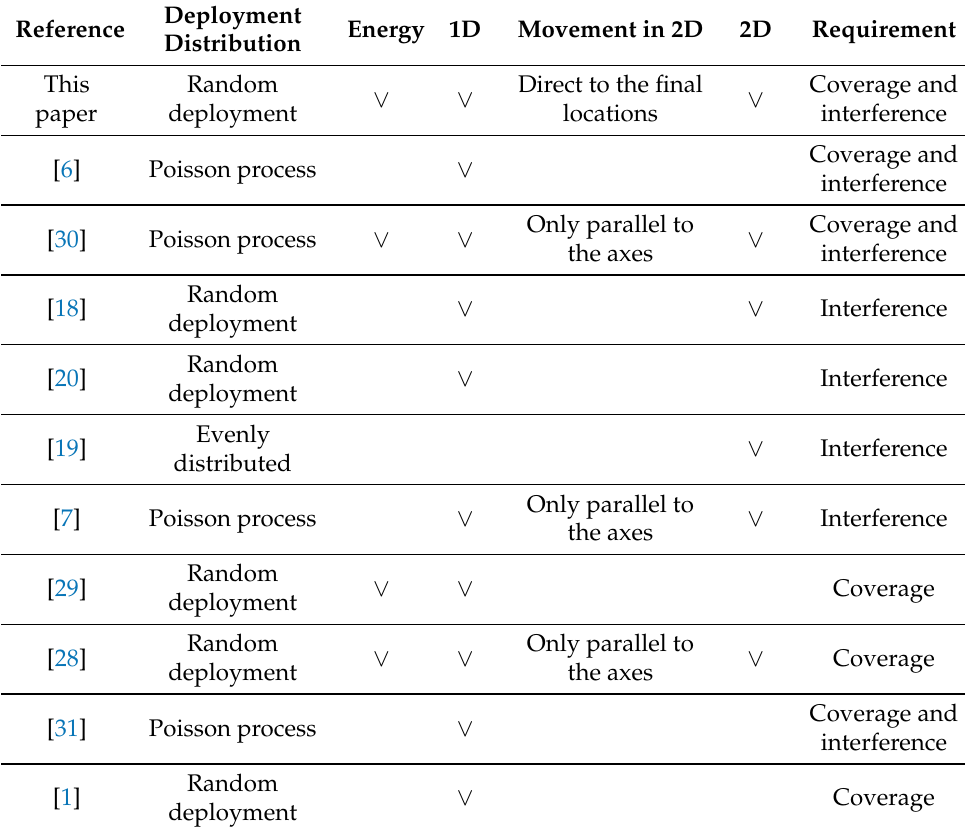
Table 3. Comparison of related papers provided that the symbol ∨ means it is